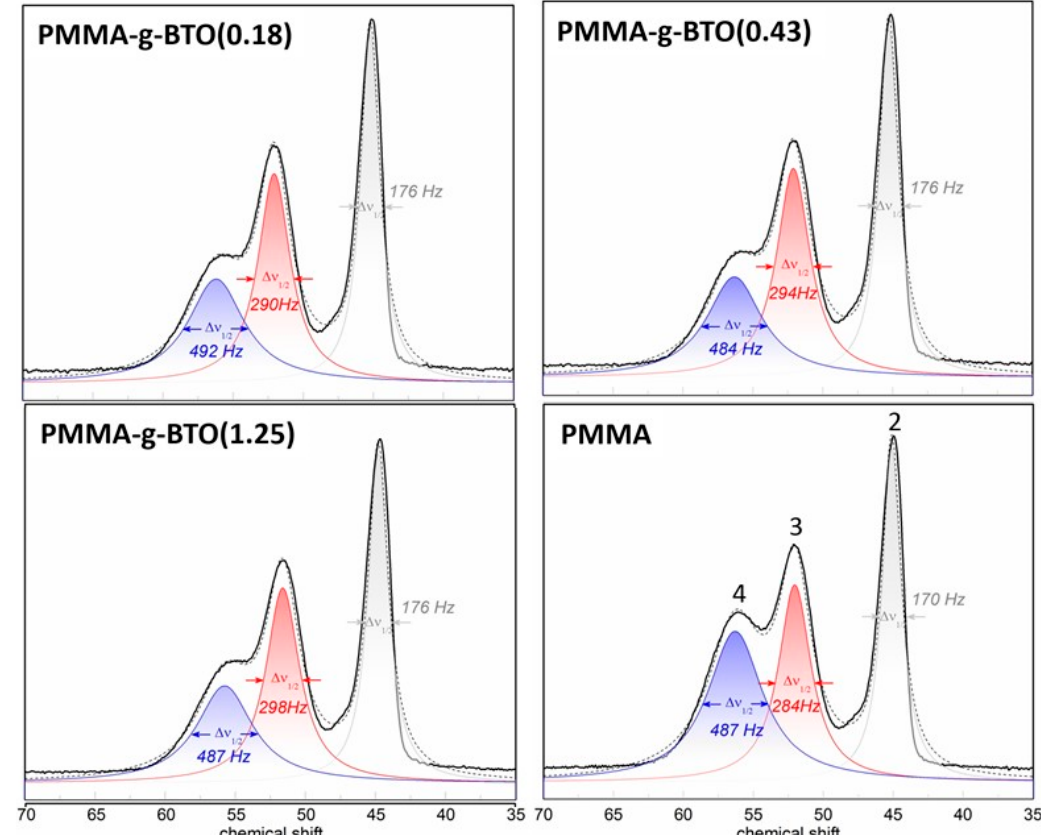
Figure 6. Deconvoluted NMR data and individual Lorentzian components half-width analysis.